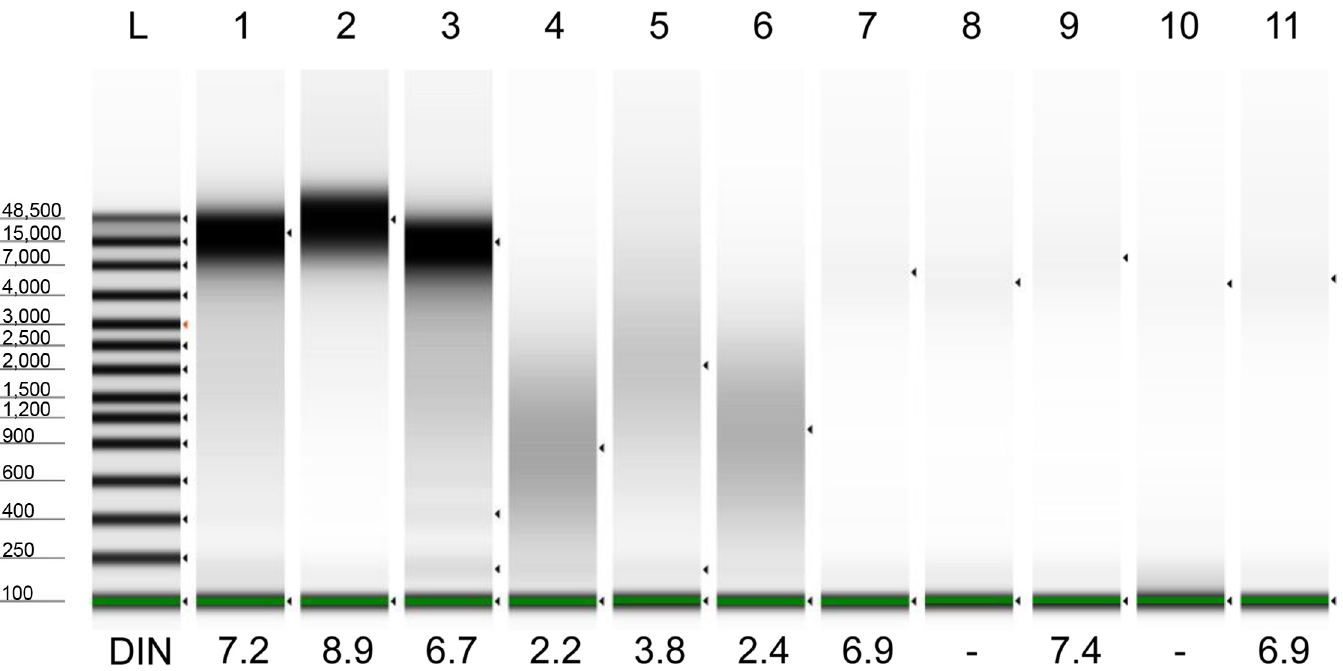
Fig 2. Electrophoresis of DNAs by Agilent 2200 TapeStation. DNAs (100 ng/lane) were electrophoresed on an Agilent 2200 TapeStation. The DNA integrity number (DIN) indicates the fragmentation of genomic DNA on a scale from 1 to 10. A high DIN indicates highly intact DNA, and a low DIN indicates strongly degraded DNA. Lane 1, Frozen-H1; lane 2, Frozen-H2; lane 3, Frozen-H3; lane 4, FFPE-H1; lane 5, FFPE-H2; lane 6, FFPE-H3; lane 7, Trizol-h1; lane 8, Trizol-h2; lane 9, Trizol-h4; lane 10, Trizol-h6; and lane 11, Trizol-h7. doi:10.1371/journal.pone.0150528.g002 PLOS ONE | DOI:10.1371/journal.pone.0150528 March 3,